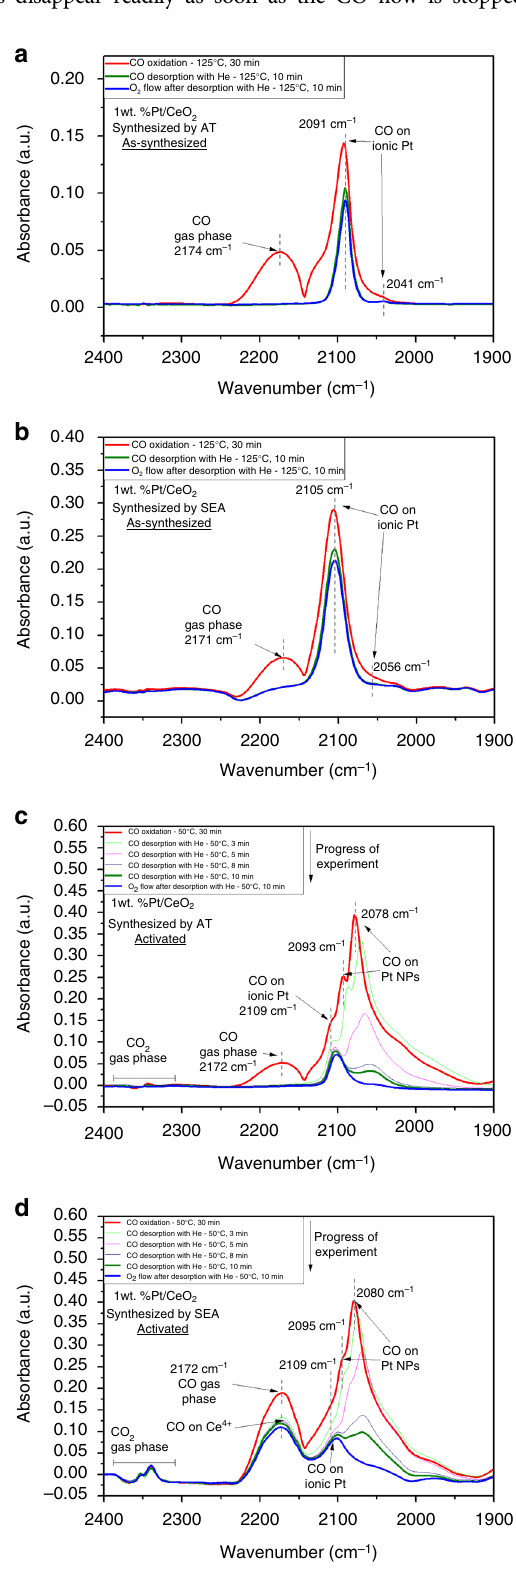
Fig. 3 CO oxidation reaction monitored by DRIFTS on the 1wt% Pt/CeO 2 TAPN catalysts: a as-synthesized AT (125 °C), b as-synthesized SEA (at 125 °C), c activated AT (50 °C), d activated SEA (50